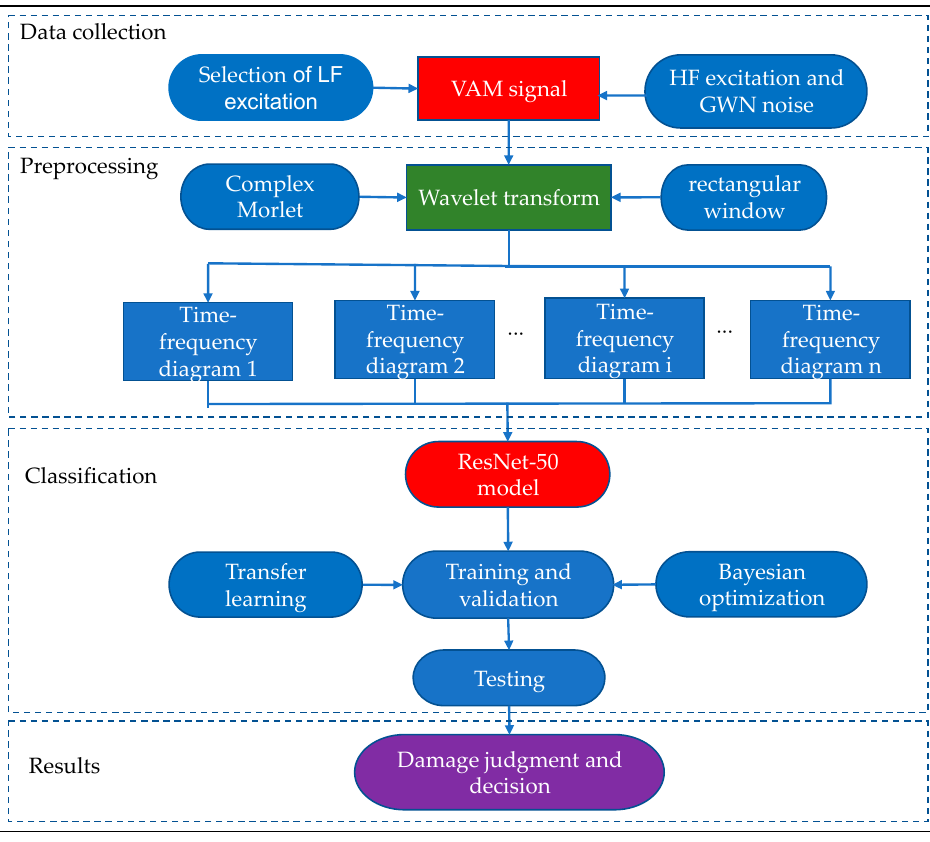
Figure 4. Multi-bolt loosening identification flowchart.